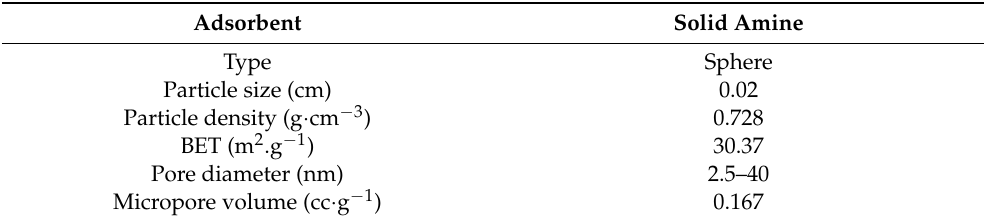
Table 1. The details of the